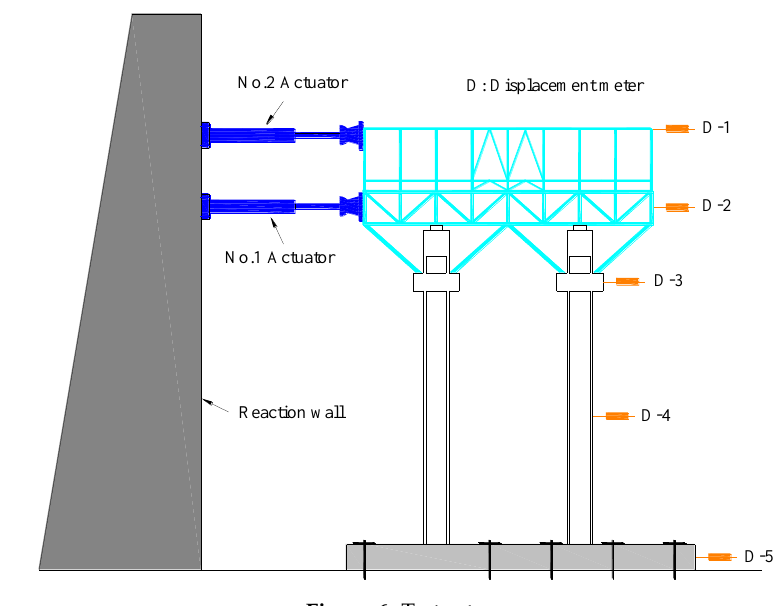
Figure 6. Test setup.